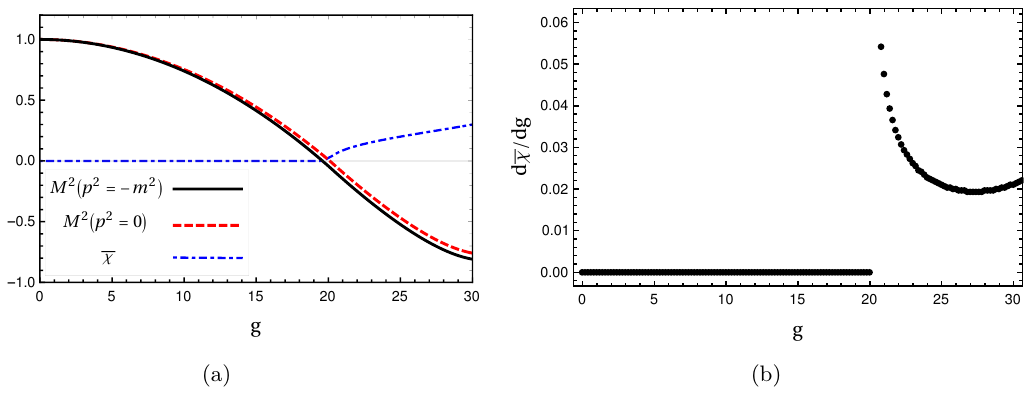
Figure 1 . Panel a: M 2 /m 2 as a function of g for M 2 ( p 2 = − m 2 ) (solid line), M 2 ( p 2 = 0) (dashed line) and the VEV χ (dash-dotted line). Panel b: the susceptibility dχ/dg as a function of g